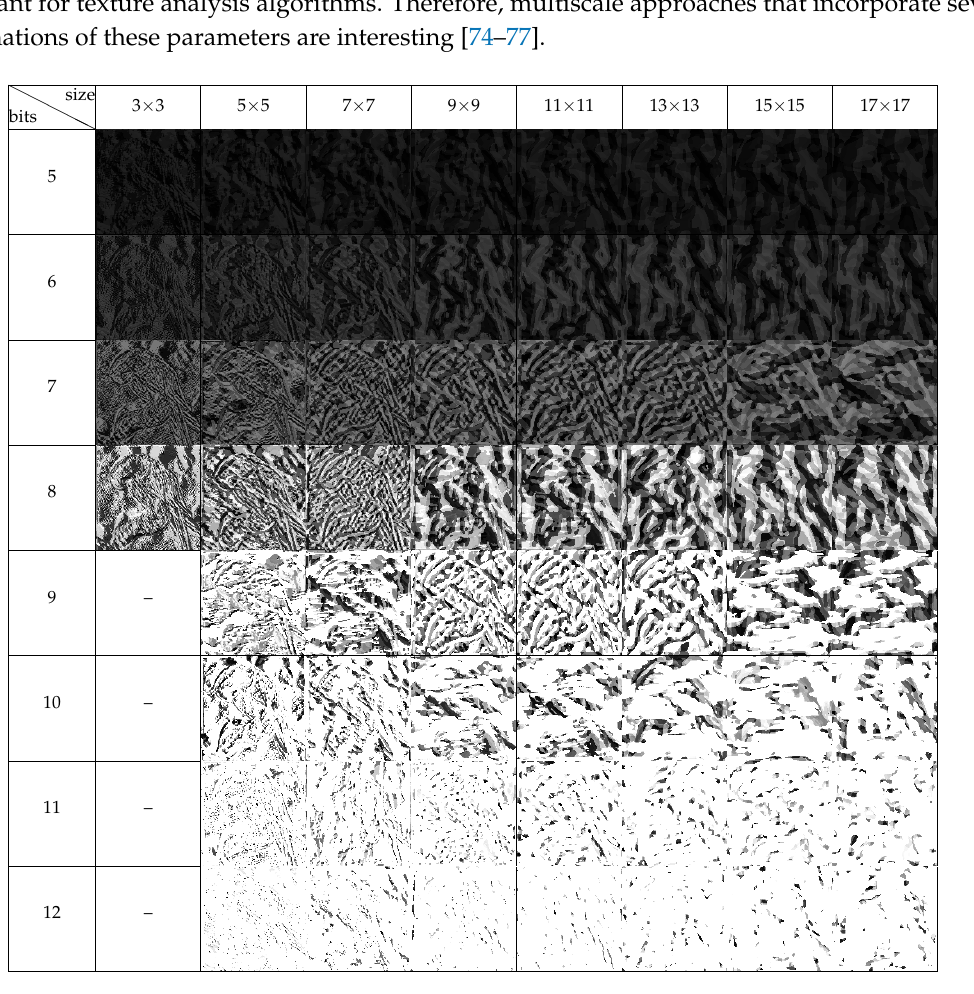
Figure 6. BSIF code images at different